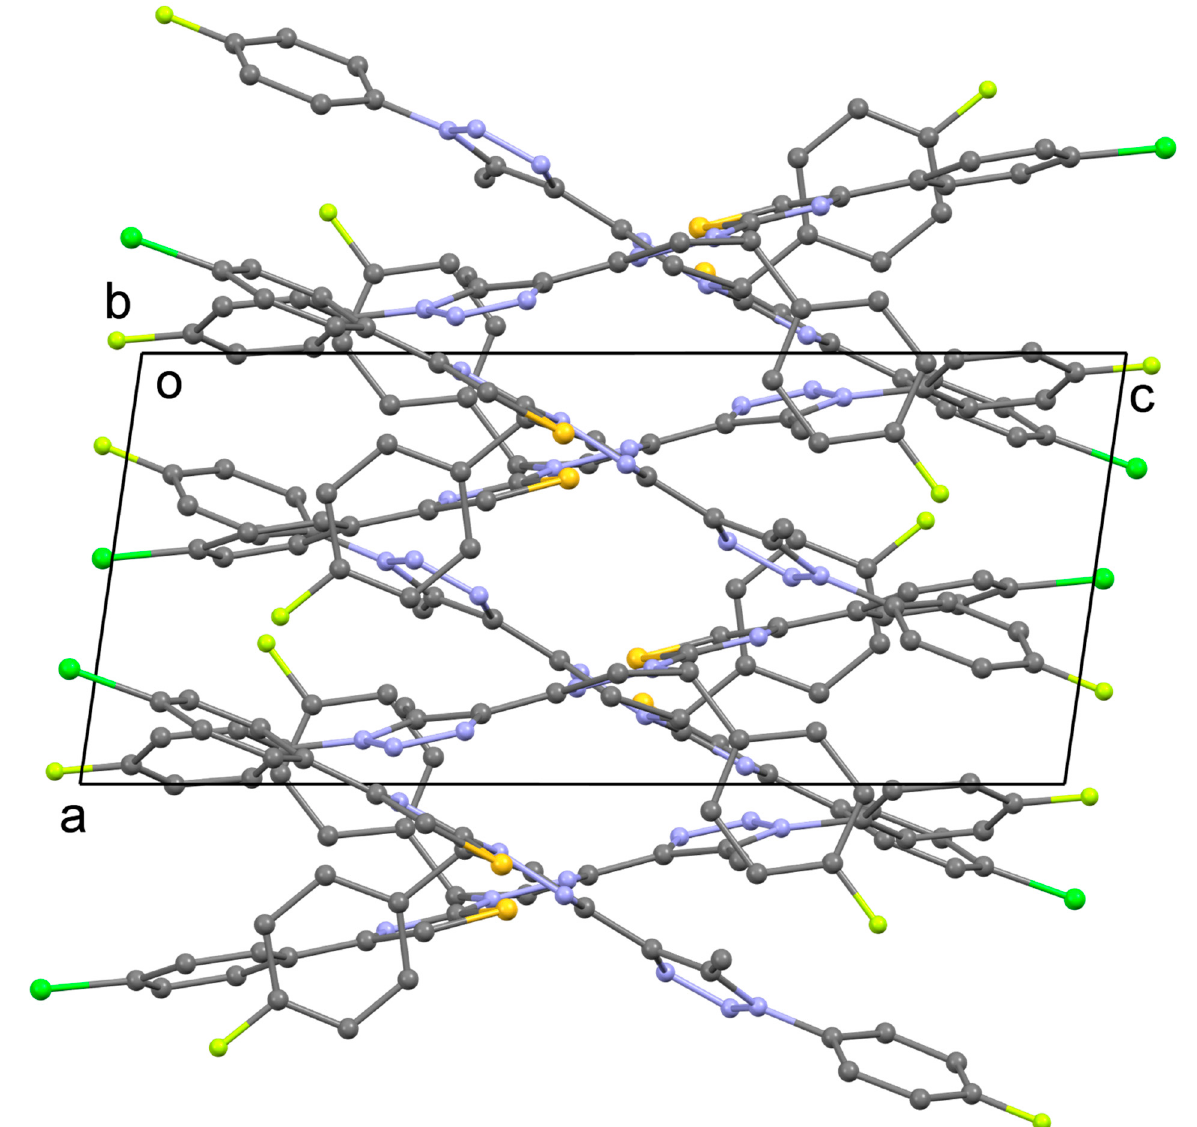
Figure 4. The crystal structure of 4 viewed down the b -axis with hydrogen atoms omitted for clarity.